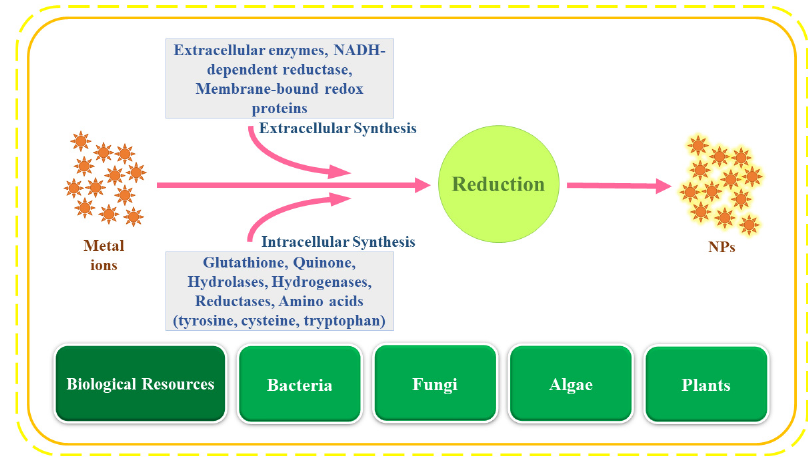
Figure 5. Brief mechanisms of nanoparticle synthesis.